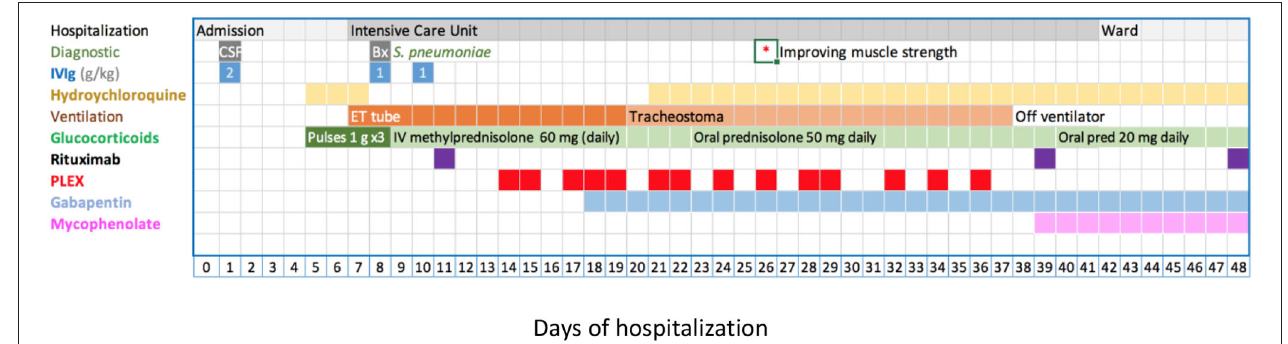
FIGURE 3 | Disease evolution and management. Treatment details see text. Briefly, IVIG 2 g/kg as a single (day 1) or fractionated dose (days 8, 10), methylprednisolone 1 g/dose (20 mg/kg/dose), rituximab 375 mg/m 2 /dose. PLEX was against albumin and occasional units of fresh frozen plasma. CSF, cerebro-spinal fluid; ET, endotracheal tube; IVIG, intravenous immunoglobulin; PLEX, plasma exchange; *indicates the day, when an improvement of muscle strength was first